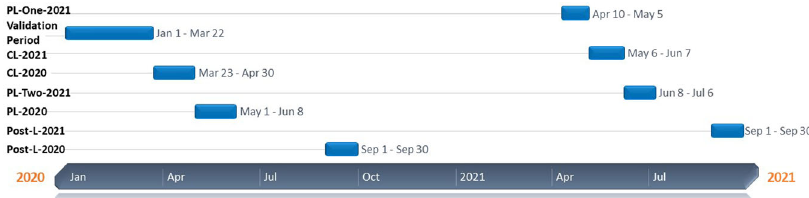
Fig. 4 Timeline of the fi rst two waves of COVID-19 lockdowns in Tamil Nadu, India. Horizontal axis: discrete intervals — various lockdown phases in both waves in Tamil Nadu. Vertical axis: time period of various